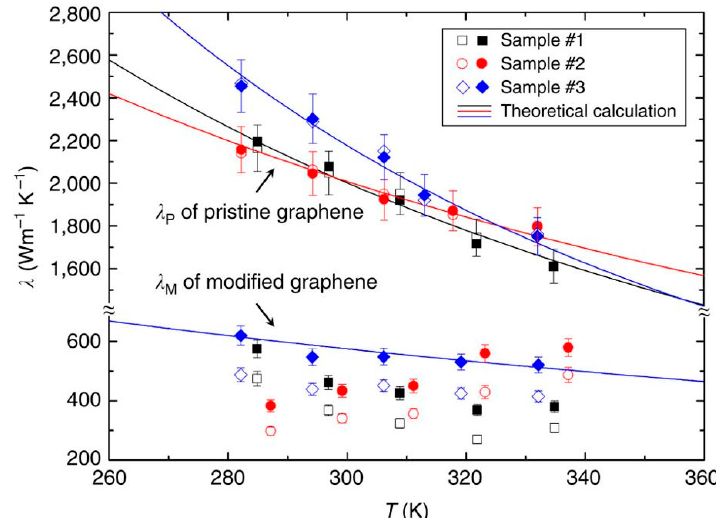
Figure 6. Comparison between measured thermal conductivity as a function of sample temperature before and after drilling nanopores. Reprinted with permission from Springer Nature Publishing Group.